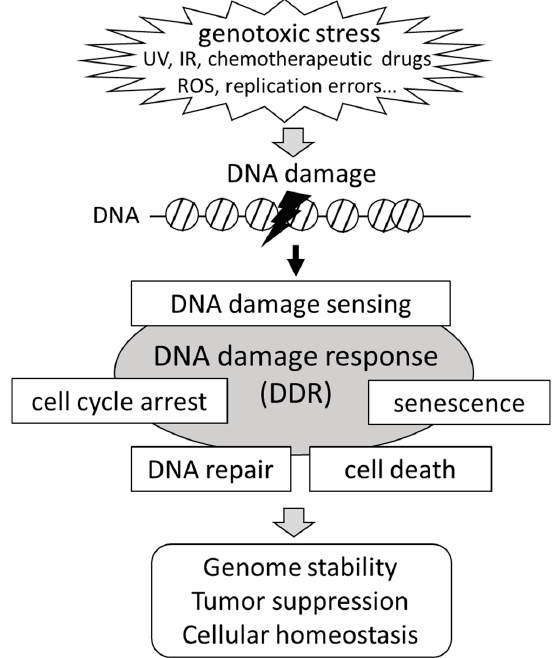
Figure 1. Schematic representation of the DNA damage response (DDR). Cells are constantly exposed to various environmental or endogenous genotoxic agents. Through the DDR pathway, the DNA various cellular events, including cell cycle arrest, DNA repair, cellular senescence, or cell death. The IR, ionizing radiation; ROS, reactive oxygen